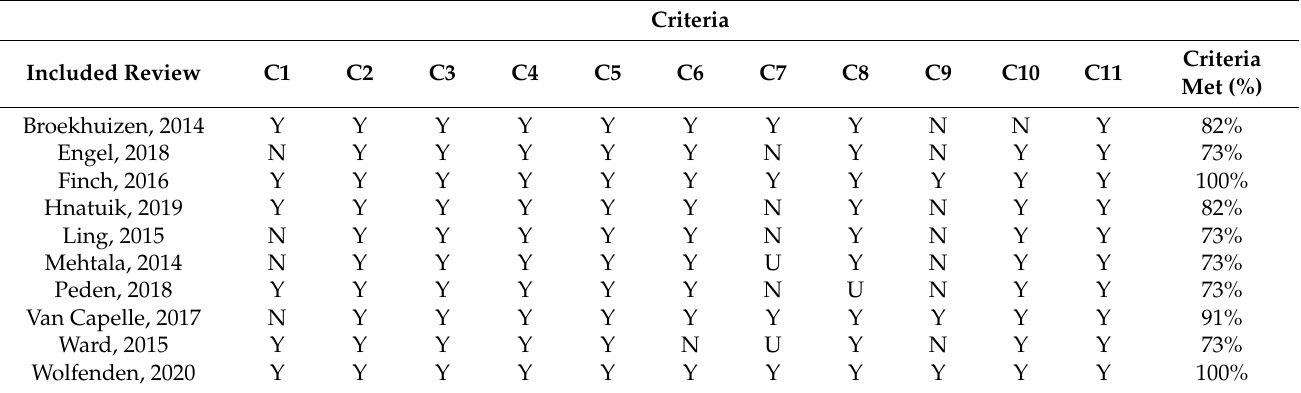
Table 2. Quality assessment of the included reviews, assessed against the JBI Critical Appraisal Checklist for Systematic Reviews and Research